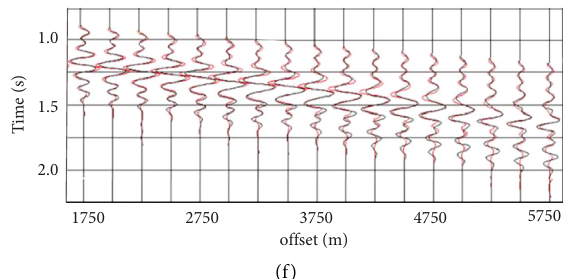
Figure 6: The synthetic tests: (a) the target model with a hidden layer; (b) the travel time tomography results; (c) the inverted model of the L2-norm EWI; (d) the inverted model of the W2-norm EWI; (e) waveforms fitting of early arrival between the synthetic data (red) and observed data (black) for the L2-norm EWI; and (f) waveforms fitting of early arrival between the synthetic data (red) and observed data (black) for the W2-norm